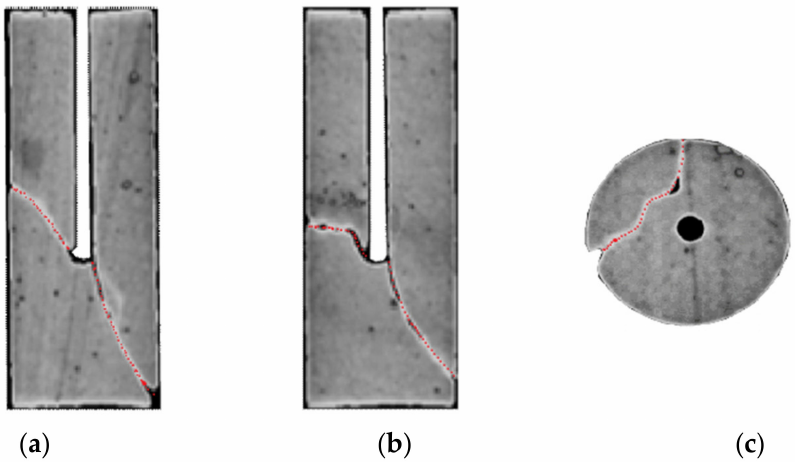
Figure 6. CT scanning profiles of the sample after hydraulic fracturing, x-z plane ( a ), y-z plane ( b ), and x-y plane ( c ). Red dots highlight the traces of